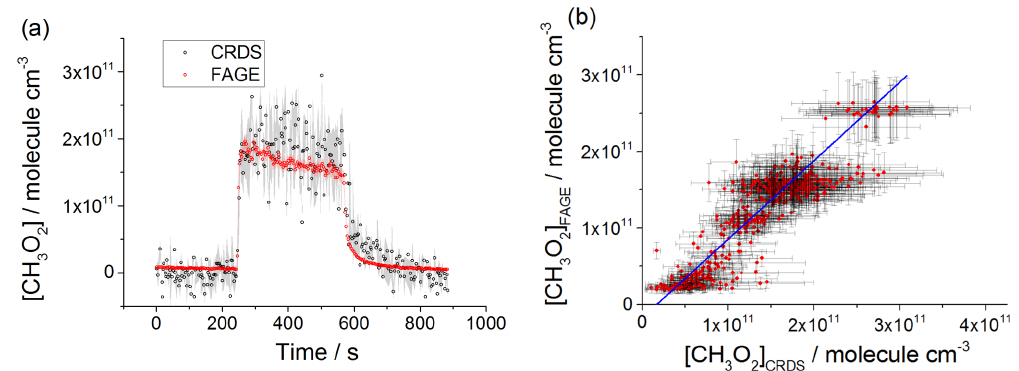
Figure 6. (a) Comparison of CH 3 O 2 measurement at 80mbar He / O 2 (3 : 1) where the lamps were turned on at t ∼ 250s for ∼ 5min to generate CH 3 O 2 and then turned off again. The measurement by FAGE is shown in red and the measurement by CRDS is plotted in black. CH 3 O 2 radicals were generated using the 254nm photolysis of ( CH 3 ) 2 CO (8 . 8 × 10 14 moleculecm − 3 ) . The 1 σ statistical errors generated by the data averaging are shown as grey (CRDS) and red (FAGE) shadows. (b) Correlation plot at 80mbar He / O 2 (3 : 1) combining the data obtained using acetone/O 2 and 254nm lamps with the data generated using Cl 2 /CH 4 / O 2 and UV black lamps. [CH 3 O 2 ] measured by FAGE is plotted against [CH 3 O 2 ] measured by CRDS. The linear fit to the data generates a gradient of 1 . 03 ± 0 . 05 and an intercept of ( − 1 . 7 ± 0 . 5 ) × 10 10 moleculecm − 3 . The linear fits were generated using the orthogonal distance regression algorithm; fit errors at the 2 σ level. In both panels [CH 3 O 2 ] FAGE was determined using a calibration factor of 3 . 83 × 10 − 9 countscm 3 molecule − 1 s − 1 mW − 1 , and